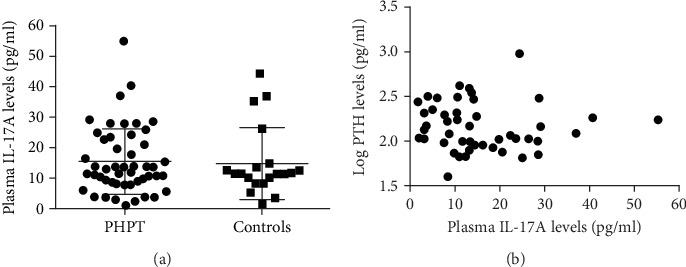
(a) Circulating IL-17A levels in postmenopausal PHPT women (black circles) compared with postmenopausal non-PHPT women (controls; black squares). (b) Correlation between circulating IL-17A levels and log PTH levels in PHPT women.